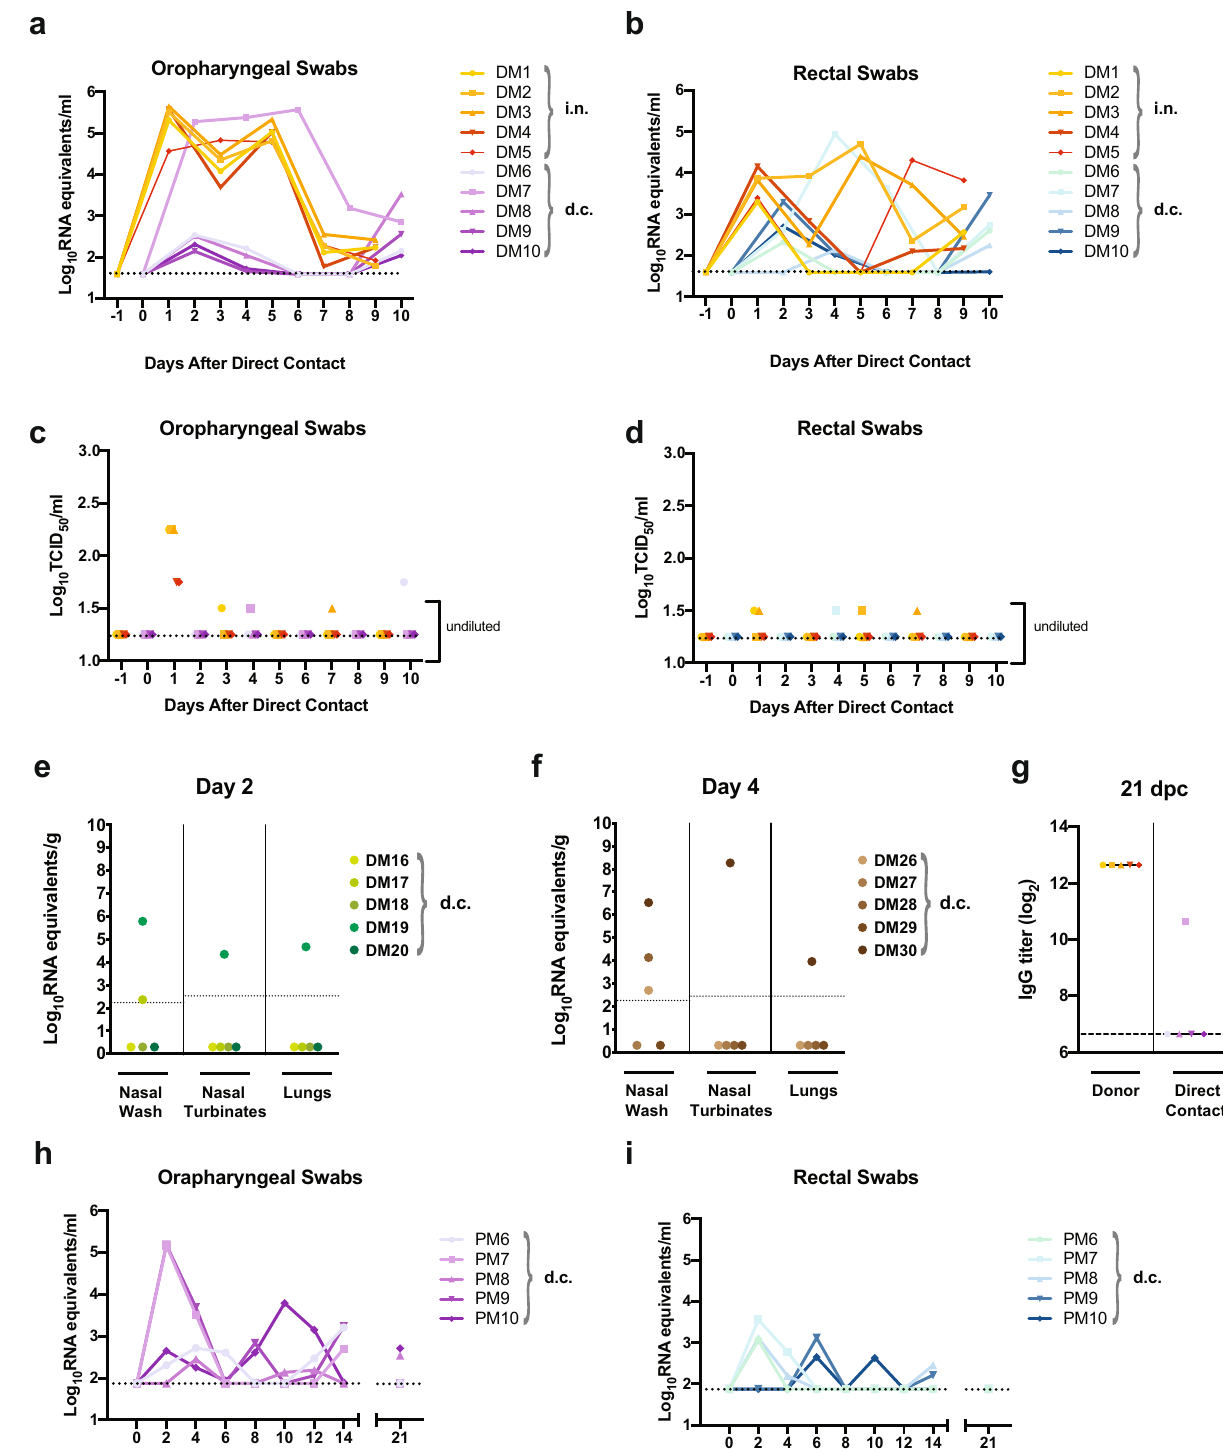
studies we describe translate to the risk of sustained transmission within wild deer mouse populations. The theoretical risk of zoonotic transmission of SARS-CoV-2 back to humans from Peromyscus species rodents would depend on additional unknowns such as whether infectious virus is present in excreta at high enough levels to initiate human infection and whether other wild or domestic animal species might serve as an intermediary host. Efforts to monitor wild, especially peri-domestic Peromyscus